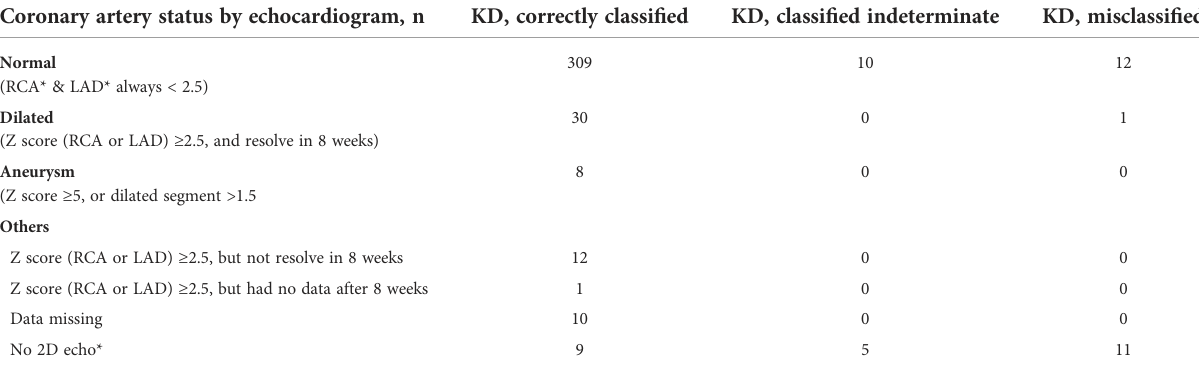
* RCA, Right coronary artery; LAD, Left anterior descending; 2D echo, 2D